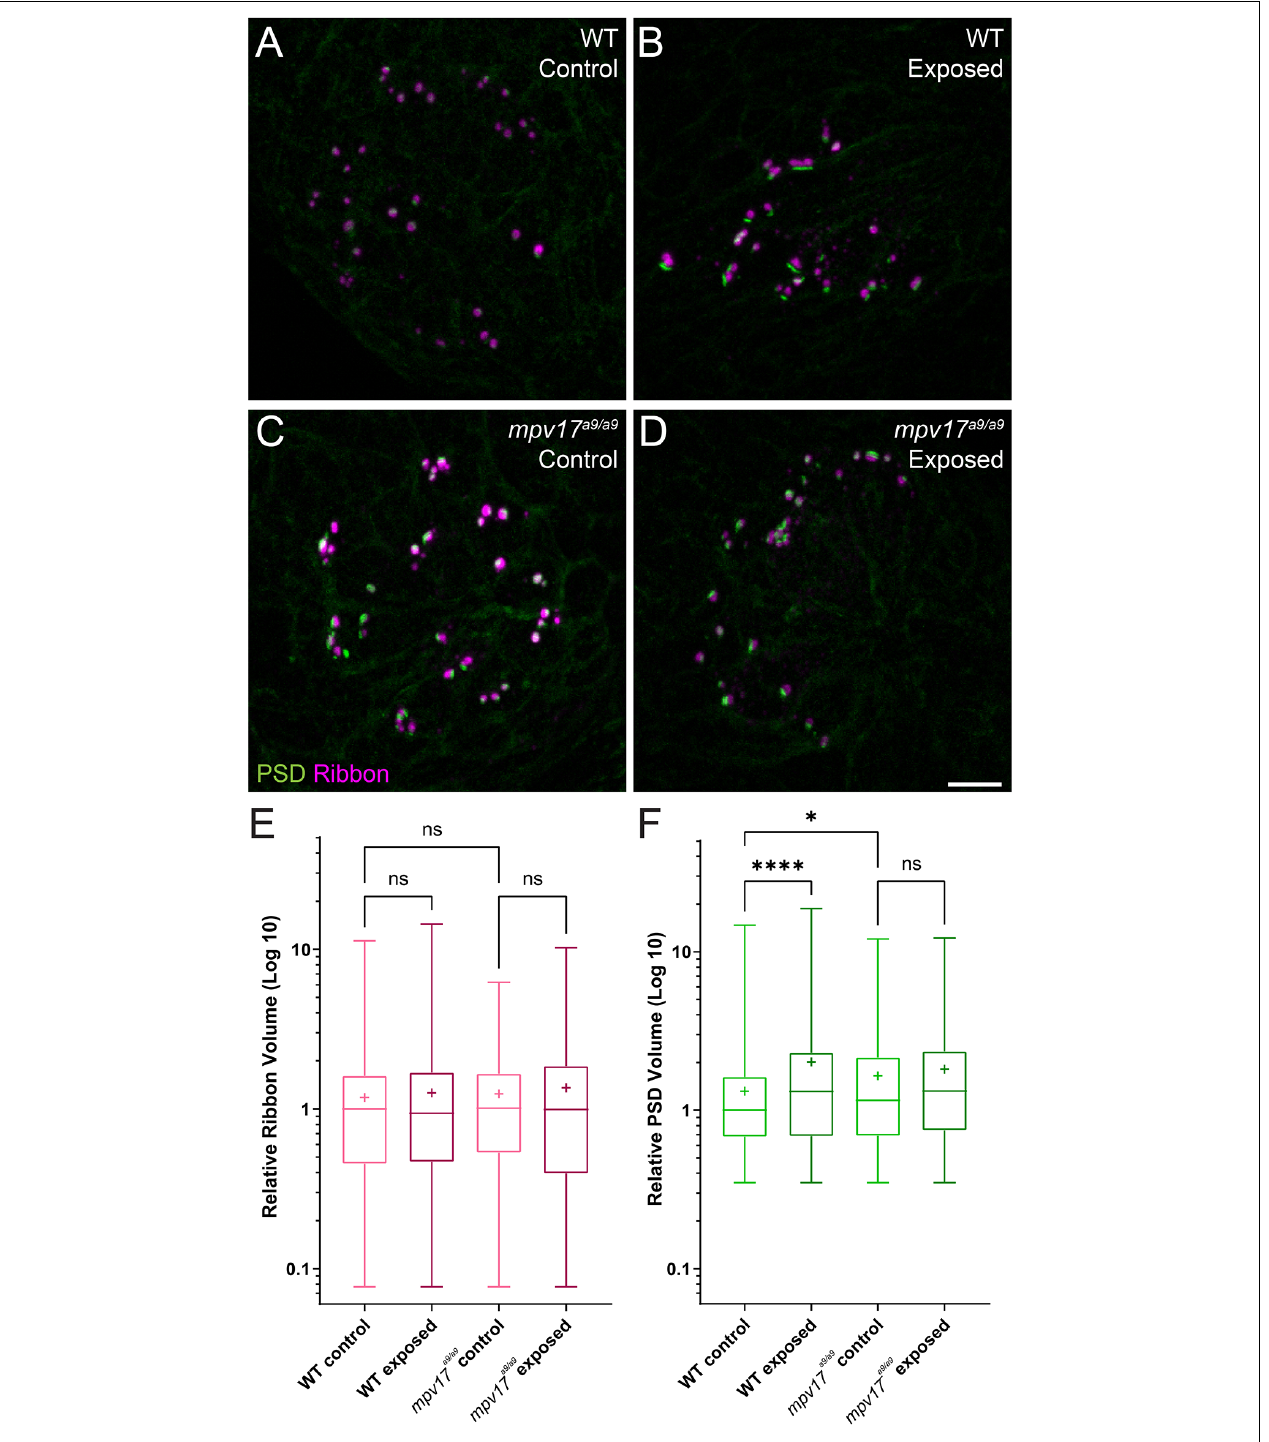
FIGURE 8 | PSDs are enlarged in mpv17 a9/a9 neuromasts but do not significantly change upon mechanical overstimulation. (A–D) Maximum-intensity projections of confocal images of WT (A,B) and mpv17 a9/a9 (C,D) neuromasts, either unexposed (A–C) or exposed to strong water current (B,D) . (E) Quantification of presynaptic ribbon volume relative to unexposed WT control. n = 1013–1087 presynaptic particles; N = 7 experimental trials. (F) Quantification of PSD volume relative to WT control. PSDs are enlarged in unexposed mpv17 a9/a9 neuromasts and mechanically overstimulated WT neuromasts, but there is no significant change in PSD size in mechanically overstimulated mpv17 a9/a9 neuromasts ( ∗∗∗∗ P < 0.0001 WT exposed; ∗ P = 0.0100 mpv17 a9/a9 control). n = 486–683 PSD particles from neuromasts L3, L4, and L5; N = 5 experimental trials. Scale bar: 5 µ m. Whiskers: min. to max. values; “+” indicates mean value. “ns” = not significant.